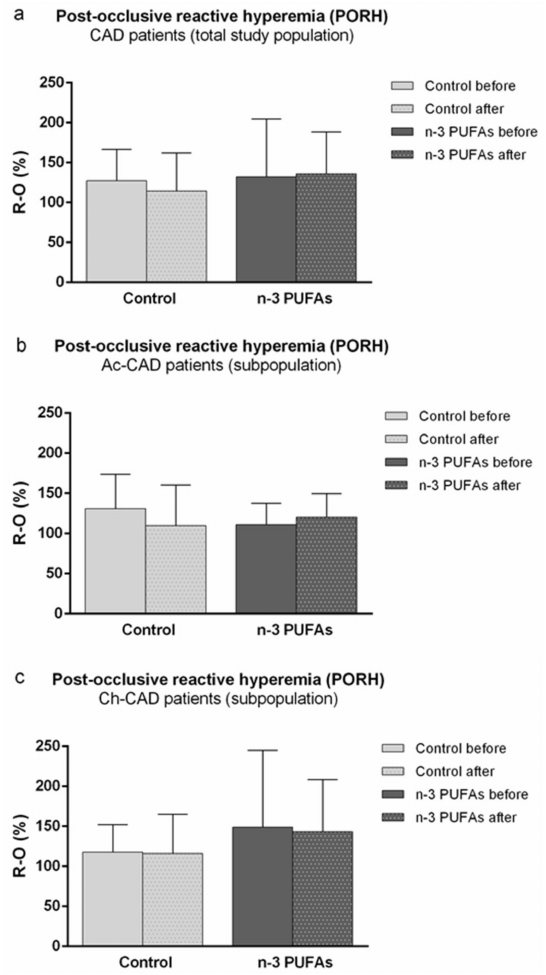
Figure 2. Three-week regular (control group) and n-3 PUFA (n-3 PUFAs group)-enriched hen egg consumption effect on skin microvascular response to vascular occlusion (postocclusive reactive hyperemia (PORH)) in ( a ) CAD patients (total study population), ( b ) Ac-CAD patients, and ( c ) Ch-CAD patients. PORH is expressed as the difference between the percentage of flow change during reperfusion and occlusion in relation to baseline (R-O%). Data are presented as the arithmetic mean ± standard deviation (SD). n-3 PUFA—n-3 polyunsaturated fatty acids, CAD—coronary artery disease; Ac-CAD—acute CAD patients; Ch-CAD—chronic CAD patients. Table 7. Effect of regular (control group) and n-3 PUFA-enriched hen eggs (n-3 PUFAs group) consumption on oxidative stress level (TBARS), antioxidant capacity (FRAP), and antioxidant enzyme (GPx) serum activity in the total population (CAD) and in the two subgroups (Ac-CAD patients and Ch-CAD